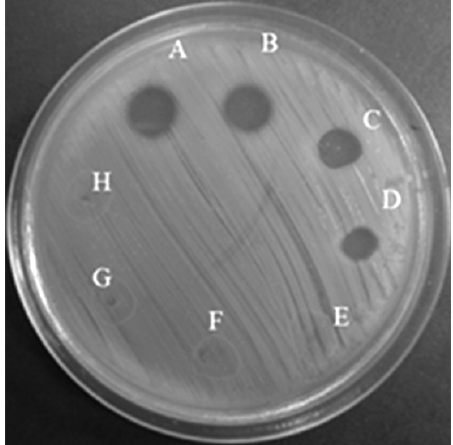
Fig. 3. Minimal arbitrary inhibition concentration of freeze-dried PS34 CFS against S. Typhimurium DMST562 (A undiluted, B 1:1, C 1:2, D 1:4, E 1:8, F 1:16, G 1:32, and H Table 4. The growth inhibition of antibiotic-resistant Salmonella and S. Typhimurium DMST562 by crude PS34 CFS (pH 4) with 0.8% lactic acid and MRS broth used as positive and negative controls. Strains Inhibition zone (mm) 24 h 36 h 48 h 0.8% MRS lactic acid